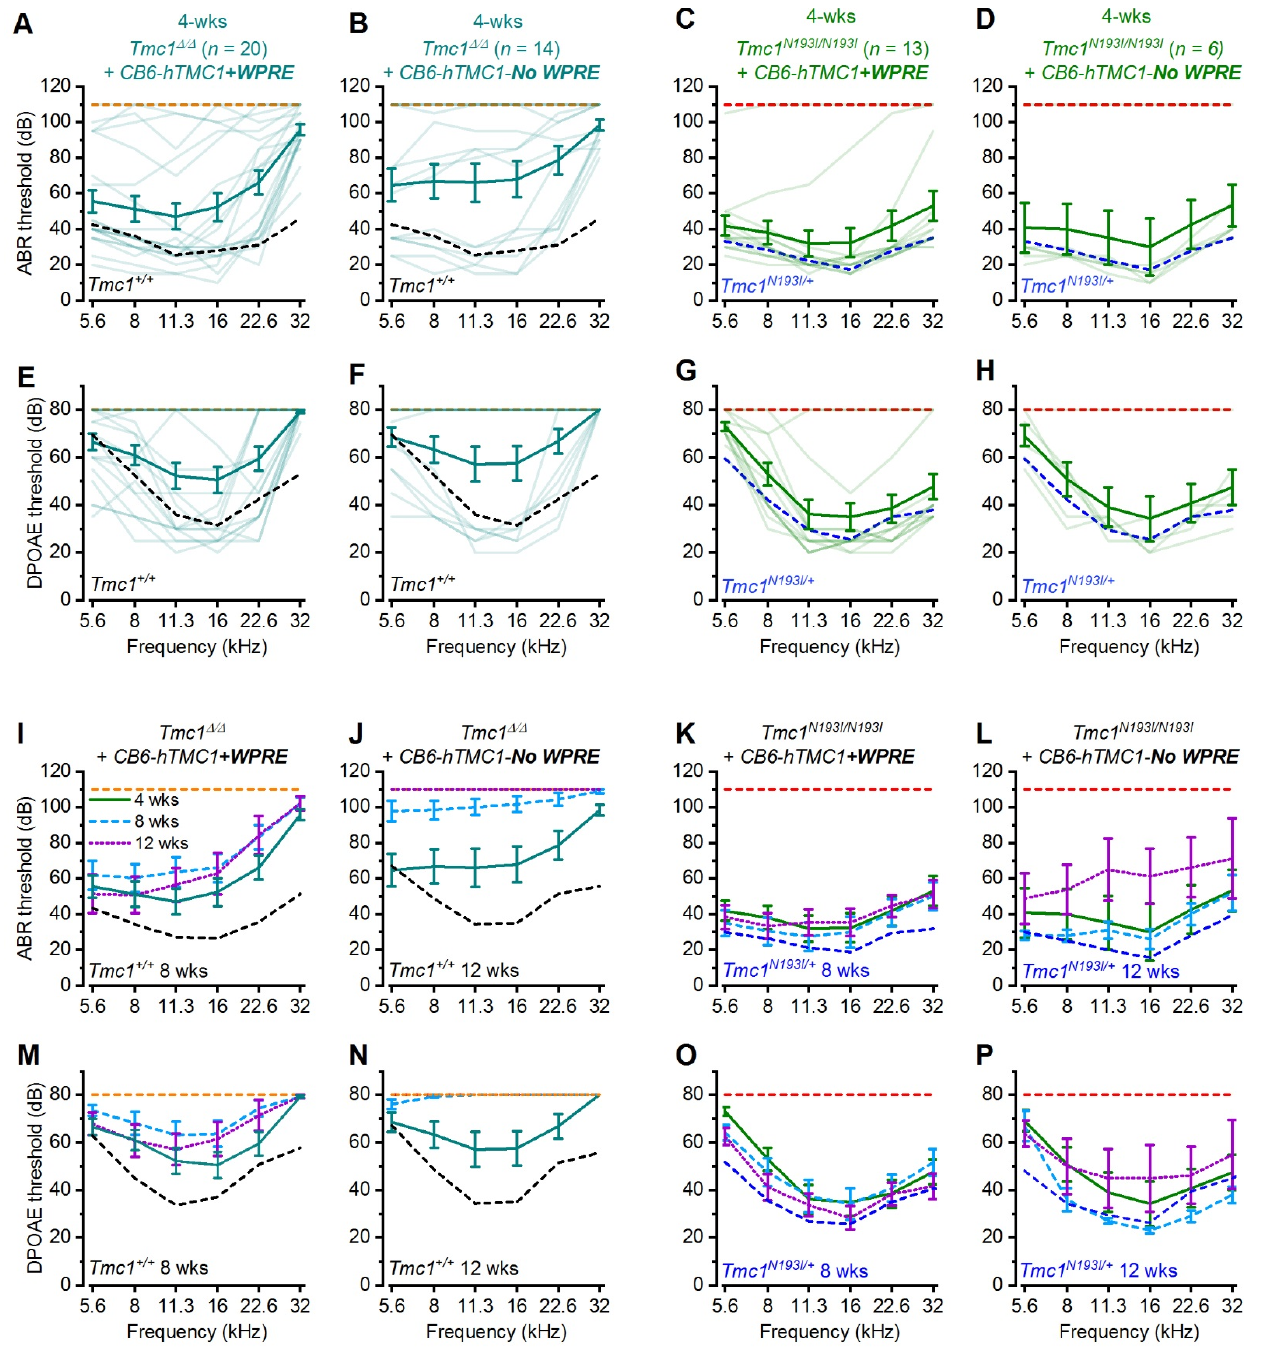
Figure 3. Deaf mice recover broad spectrum auditory capacity with AAV2/9-PHP.B -CB6-hTMC1 gene therapy. ABR ( A – D ) or DPOAE ( E – H ) thresholds as a function of frequency of Tmc1 Δ / Δ ( A , B ) ( E , F ) and Tmc1 N193I/N193I ( C , D ), ( G , H ) mice injected at P1-2 with CB6-hTMC1 + WPRE ( A , C , E , G ) or CB6-hTMC1 (No WPRE) ( B , D , F , H ) at 4 weeks of age. Mean ± S.E.M. thresholds shown in bold traces and individual recording are shown as lighter traces. Mean ± S.E.M. ABR ( I – L ) or DPOAE ( M – P ) thresholds versus frequency for injected 4- , 8- , and 12-week-old mice. Dashed lines indicate mean ABR or DPOAE thresholds for uninjected control mice: Tmc1 Δ / Δ (orange), Tmc1 +/+ (black) (4-week-old: ( A , B , E , F ); 8-week-old: ( I , M ); 12-week-old: ( J , N )) and Tmc1 N193I/N193I (red), Tmc1 N193I/+ (blue) (4- week-old: ( C , D , G , H ) ; 8-week-old: ( K , O ); 12-week-old: ( L , P )).